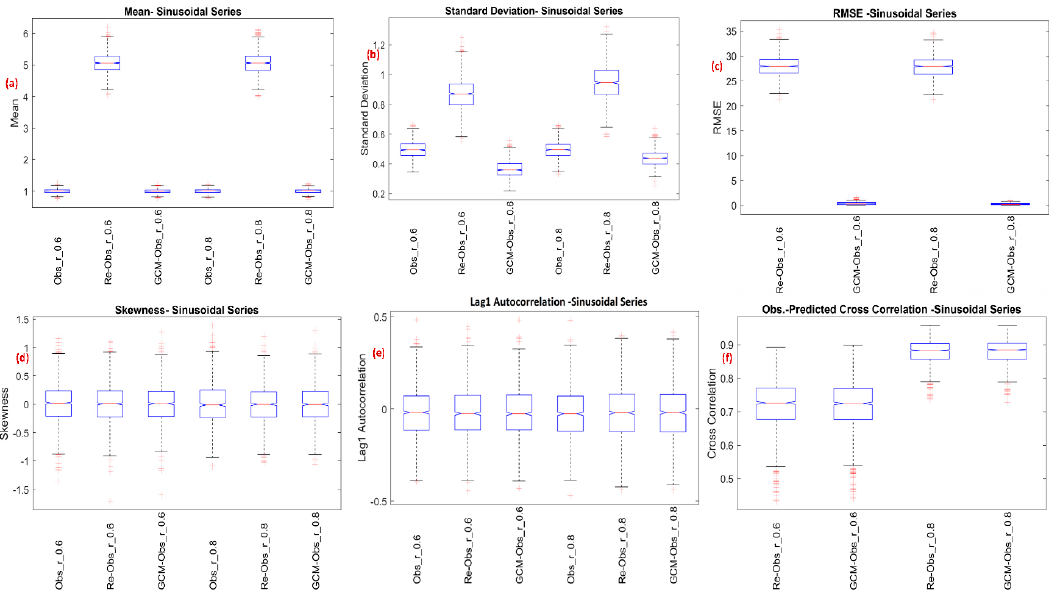
Figure 3. Comparison of predicted data with observed values using the Re-Obs and GCM-Obs models for Set2. Similarity of prediction with observed is showed by ( a ) Mean ( b ) Standard Deviation ( c ) RMSE ( d ) Skewness ( e ) Lag1 autocorrelation and ( f ) Cross correlation. Suffix 0.6 and 0.8 on x-axes labels show correlation between observed and GCM data considered for synthetic series generation.